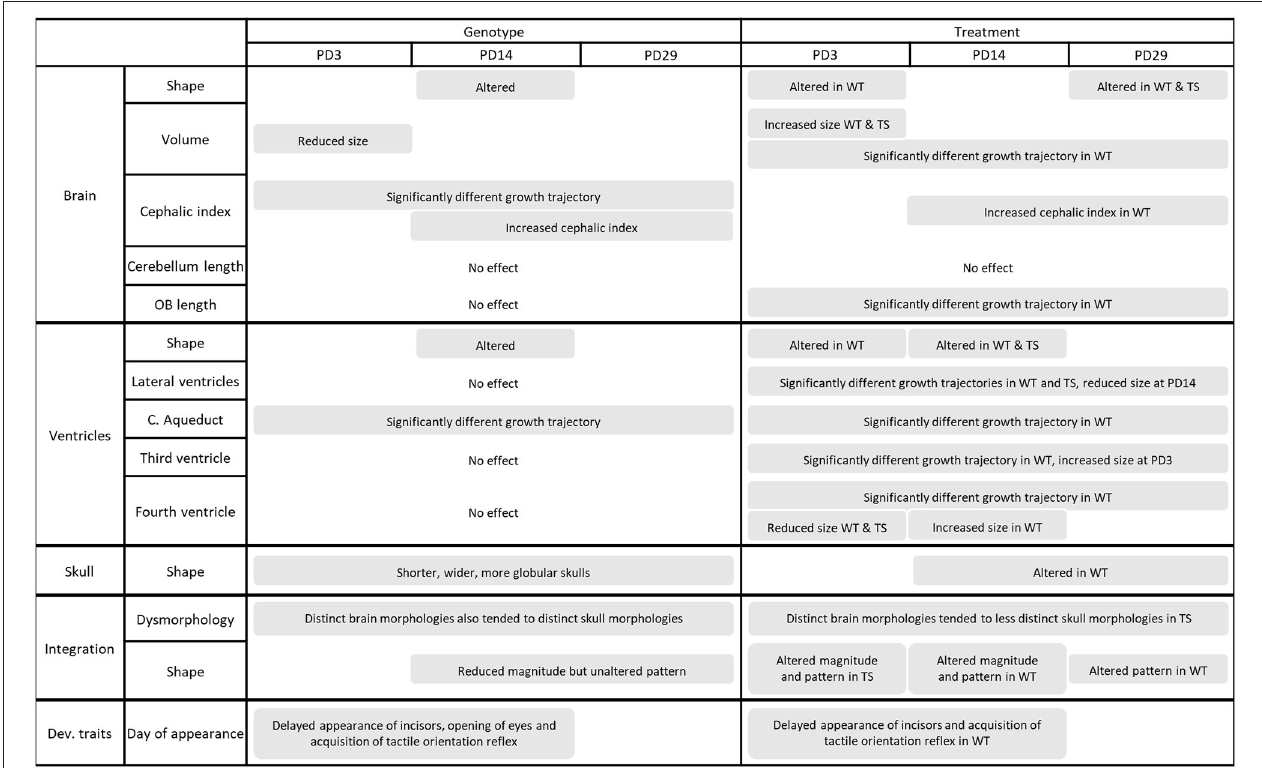
FIGURE 7 | Summary of the main findings of the current article. Each system and parameter analyzed is presented in rows. Genotype and treatment effects are presented in columns at each postnatal day (PD), presented in sub columns. OB length, olfactory bulbs length; C. aqueduct, cerebral aqueduct; Dev. Traits, developmental